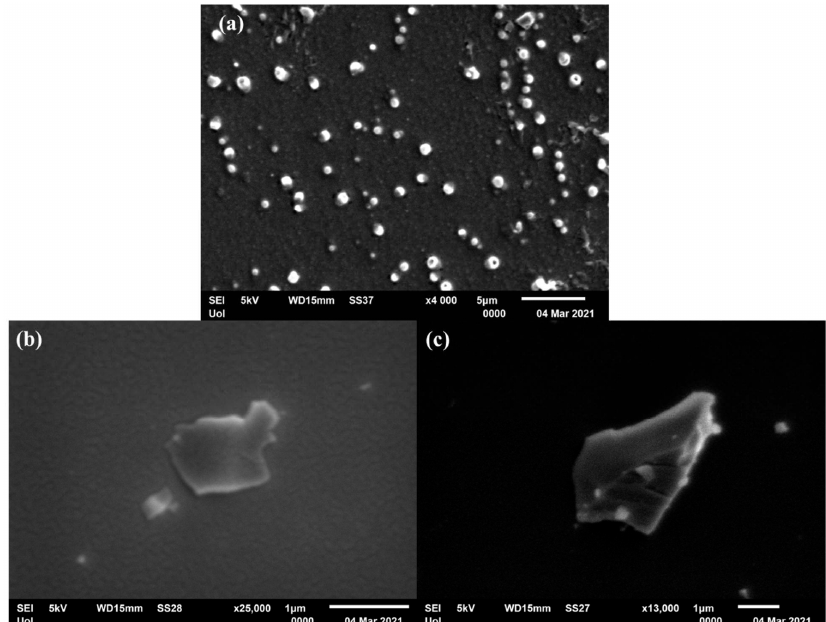
Figure 5. Scanning electron microscopy (SEM) images of ( a ) PANI and ( b,c ) carbon nanosheets. Molecules 2021 , 26 , x FOR PEER REVIEW